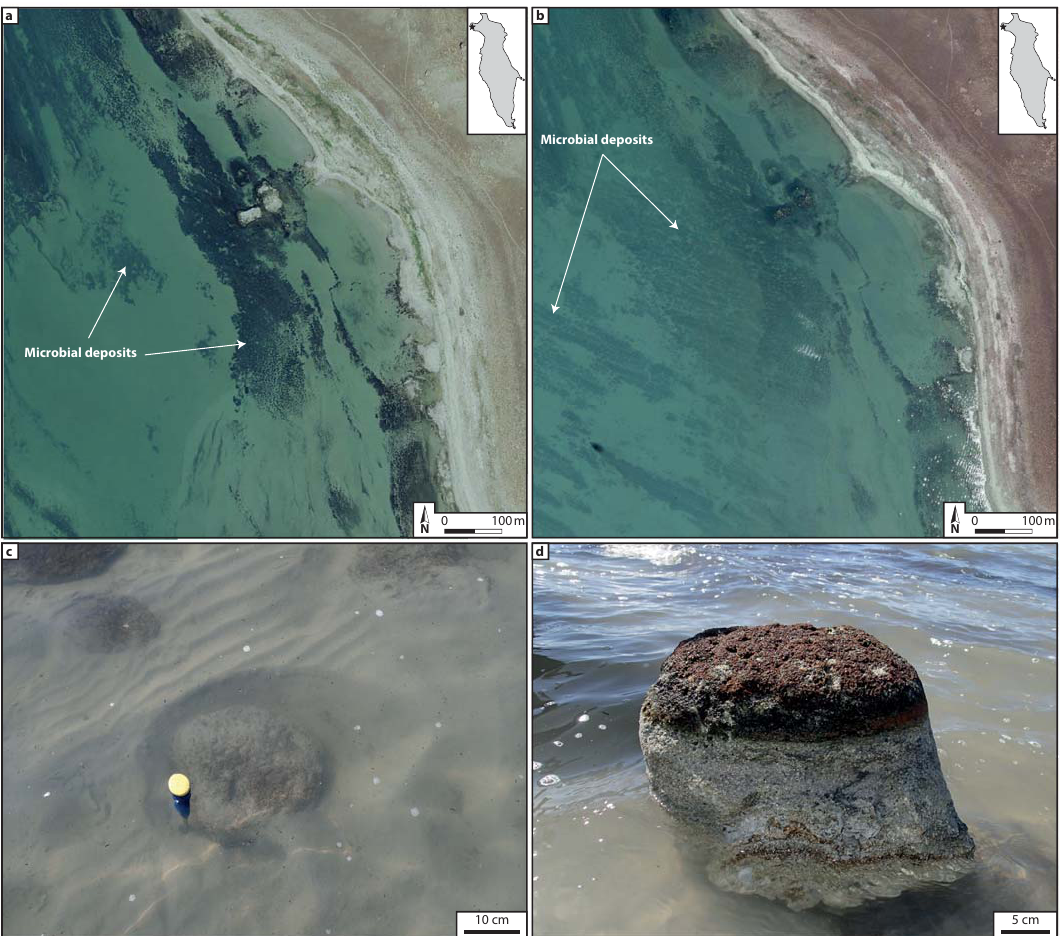
Figure 6. Illustrations of sediment removal. (a) Typical aerial/satellite images of NW Antelope Island (since 1950) with abundant microbial deposits (2014 NAIP 1m orthophotography). (b) The same area as shown in panel a showing the burial of microbial deposits in ooid sands (Digitalglobe®images through the Garmin Birdseye software; exact date unknown but probably ca. 2013). Panels (c) and (d) depict a microbial structure that is partially buried in the ooid sand; the outcropping part ( c ; 3cm high) is the only visible part; after removal from the surrounding sediment, the structure is 40cm high (d) , and the base of the column shows the attachment to an indurated